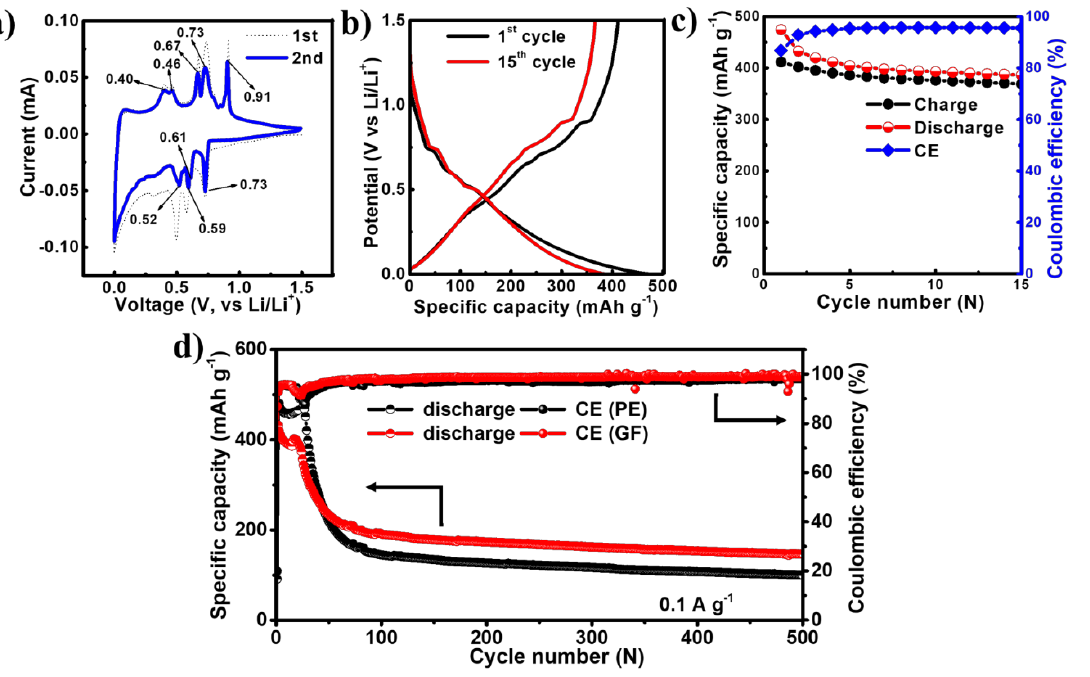
Figure 4. Electrochemical performance of EGaInSn LMNPs with a GF micro separator and PVDF binder: ( a ) CV, ( b ) typical potential profiles, ( c ) galvanostatic charge/discharge profiles at the initial stages measured with a GF separator right after the CV measurements, and ( d ) long term cycling performance of EGaInSn LMNP electrodes at 0.1 A g –1 with GF and PE separators.